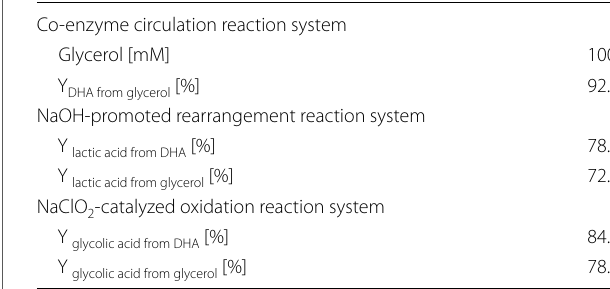
Table 1 Conversion rate of DHA to lactic acid and glycolic